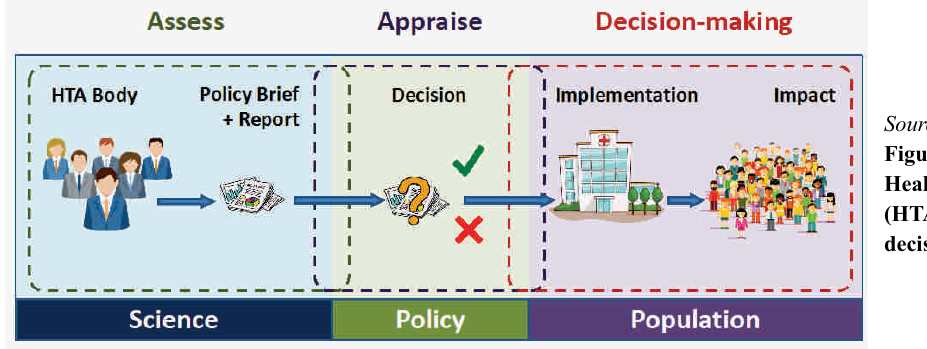
Figure 2: The process of Health Technology Assessment (HTA) evidence informed decision